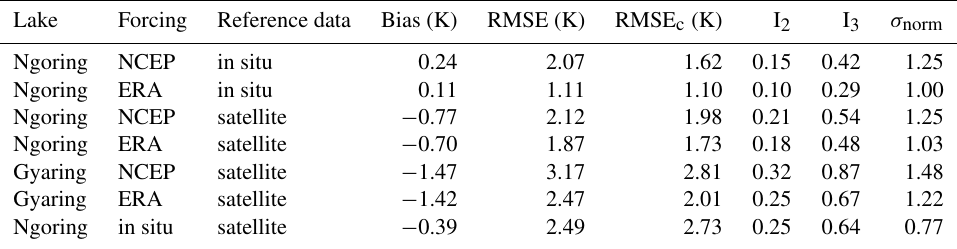
ically from the remote infrared radiation measurements. The